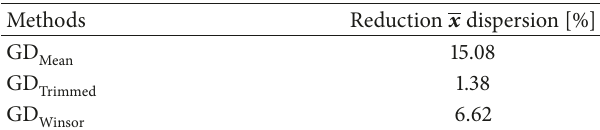
Table 17: Log-normal with 1000